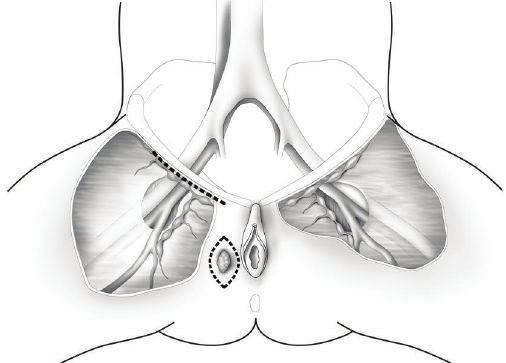
Figure 5: Radical wide excision and bilateral inguinofemoral lymphadenectomy is performed for midline vulvar cancers. This illustration depicts the right superficial inguinal lymph nodes and the left deep femoral lymph nodes which are seen along the medial aspect of the fossa